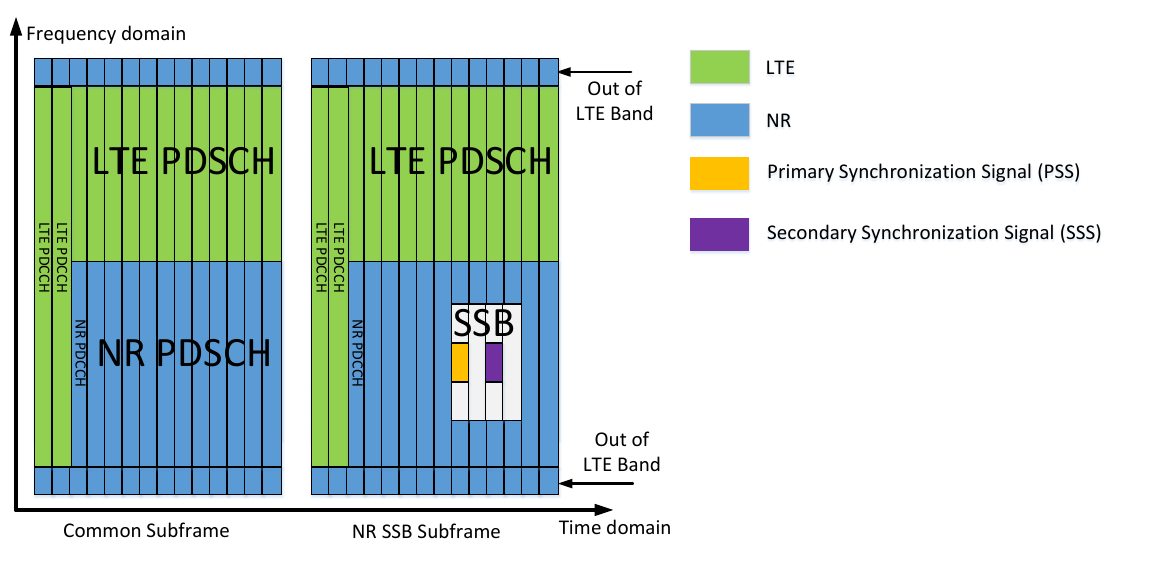
Figure 4. Downlink channel